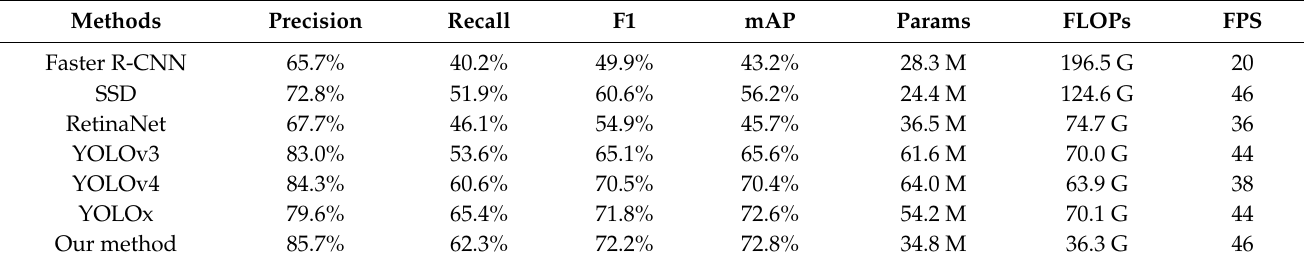
Figure 9. The detection results of our method on the wGrapeUNIPD-DL. Table 8. The experimental results on the wGrapeUNIPD-DL using different